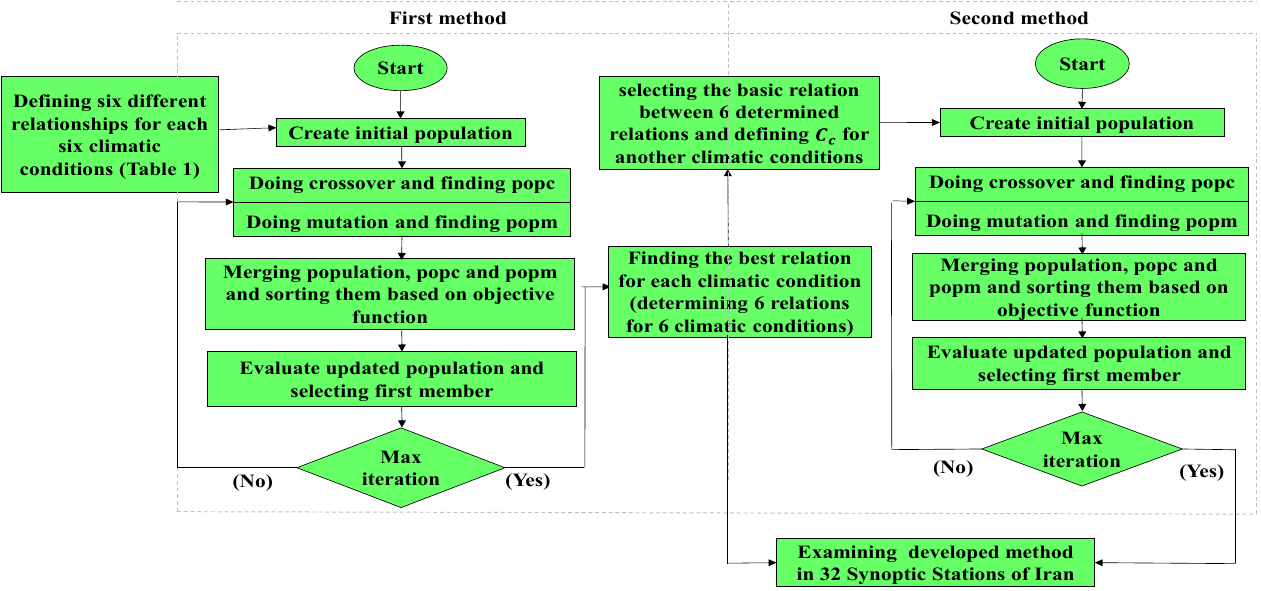
Figure 2. Outline of steps in the research process (popc: created members of children in genetic algorithm, popm: mutated members in the genetic algorithm).